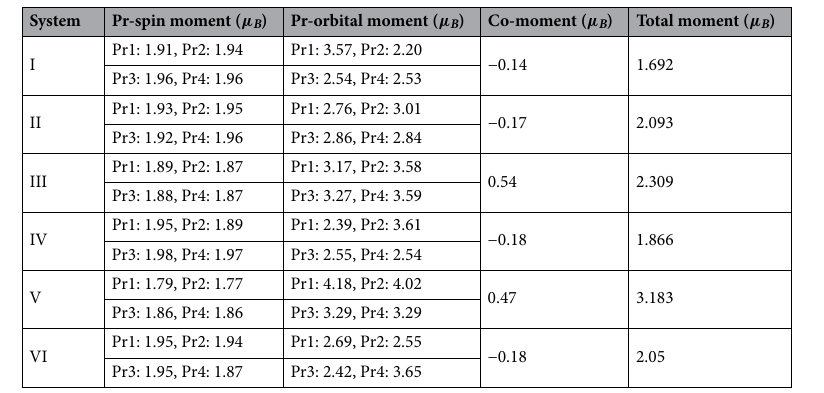
Table 3. Total magnetic moment, total spin and orbital contribution and cobalt’s magnetic moment.